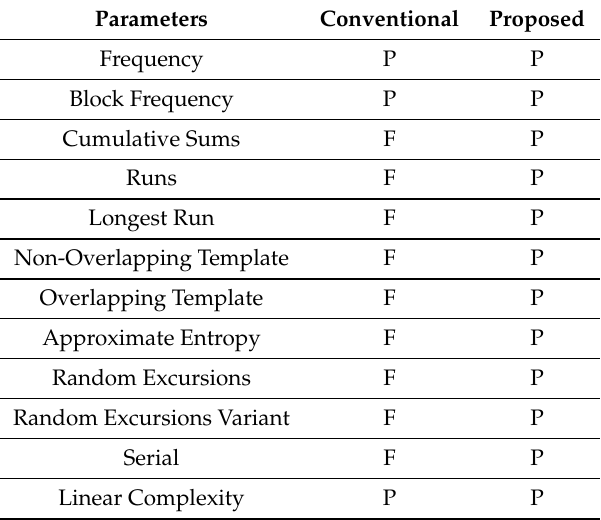
Figure 5. Random number pattern generated in true random number generator. Table 2. NIST test suite result. P: pass, F: fail.